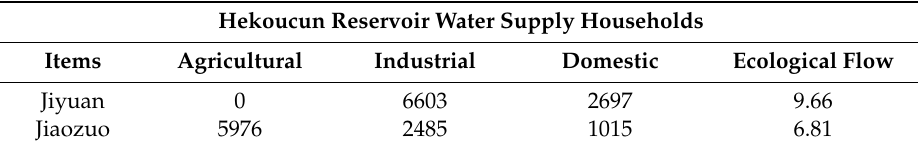
Table 1. Water demand allocation scheme of Hekoucun reservoir in 2030 (million m 3 ).